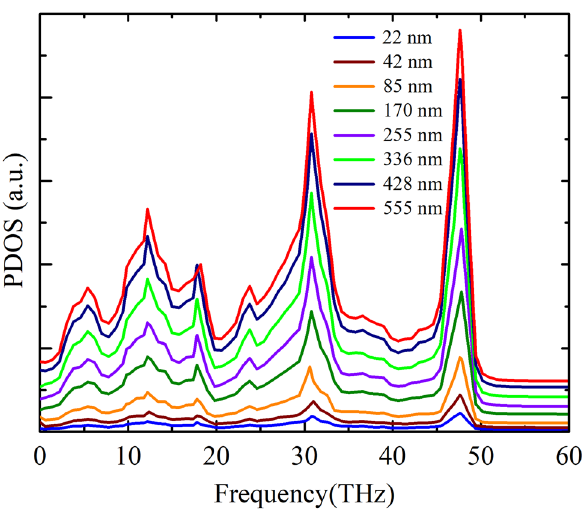
Figure 10. In-plane PDOS of the graphene/2D-SiC heterobilayer for varying lengths from 22 to 555 nm with a fixed-width of 10.8 nm at 300